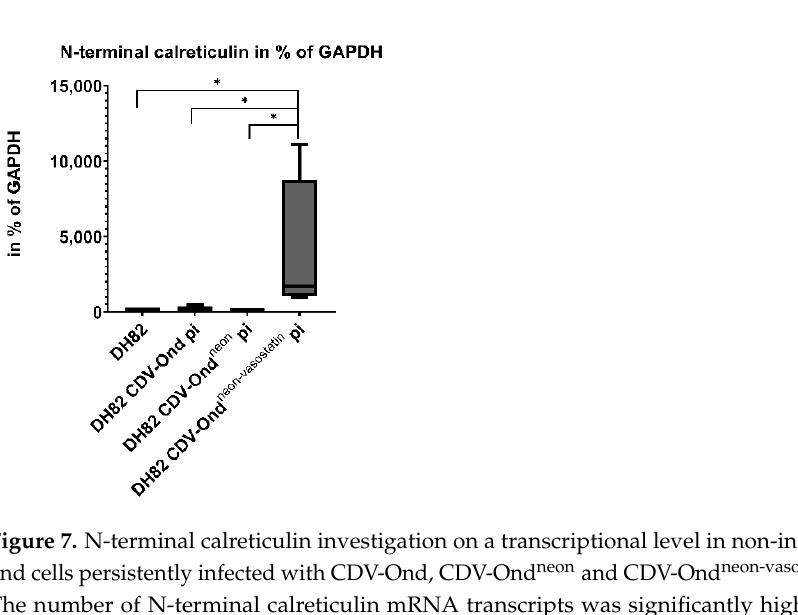
10 of 21 Table 5. Median and range of the number of N-terminal calreticulin (vasostatin) mRNA transcripts in % of GAPDH. Vasostatin mRNA Transcripts (in % of GAPDH)